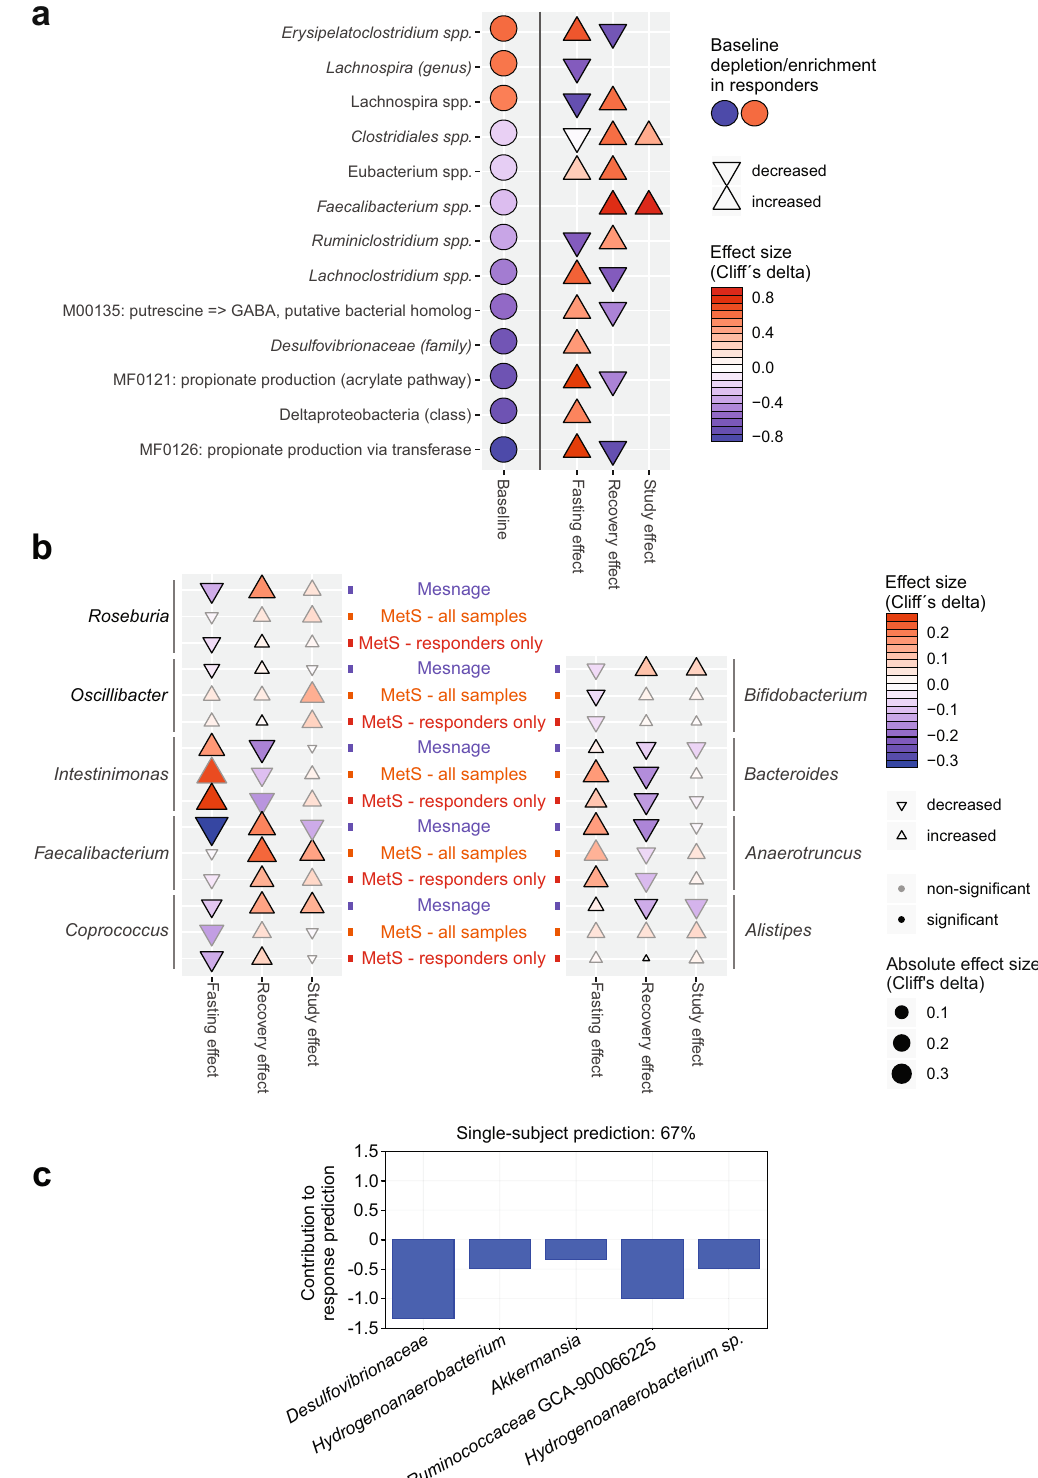
respectively). Baseline antihypertensive medication did not differ signi fi cantly between the groups (responders ’ normalized mean dose: 1.4, non-responders ’ normalized mean dose: 2.1). Addi- tionally, responders had lower median BMI than non-responders; 32.0 and 36.5, respectively. In addition, body fat percentage was